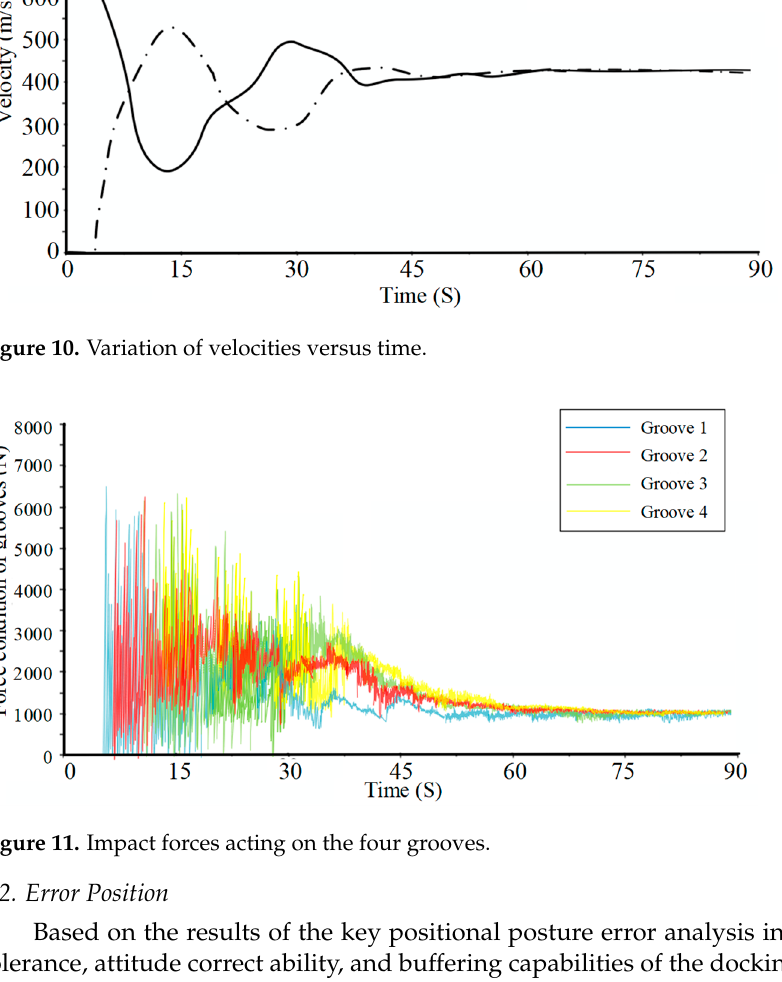
( b ) Figure 12. Position versus time of the active part: ( a ) in x direction; ( b ) in z direction 4.3. Capture Strategy Analysis The contact forces of synchronous docking capture and the proposed cooperative docking capture are compared and analyzed in the simulation, and the initial docking conditions are shown in Table 4. The docking mechanism model in the simulation envi- ronment is shown in Figure 12. As shown in Figures 13 and 14, the contact time between the capture arm and the V-shape groove is not synchronized due to the positional pos- ture error, and the peak force of the V-shape groove is 6500 N. The duration of the peak